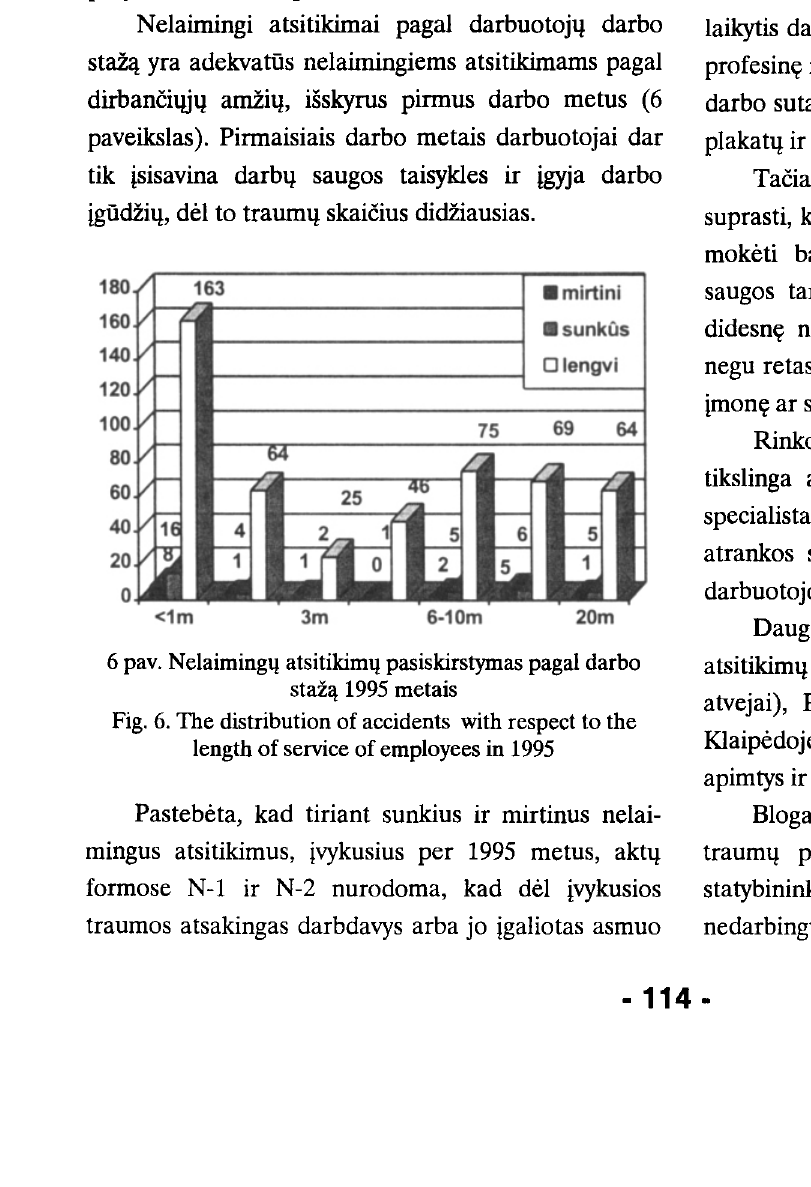
Fig. 5. The distribution of accidents with respect to the age of employees in 1995 Daugiausia traumuojama 21-60 met'q darbuotojq.